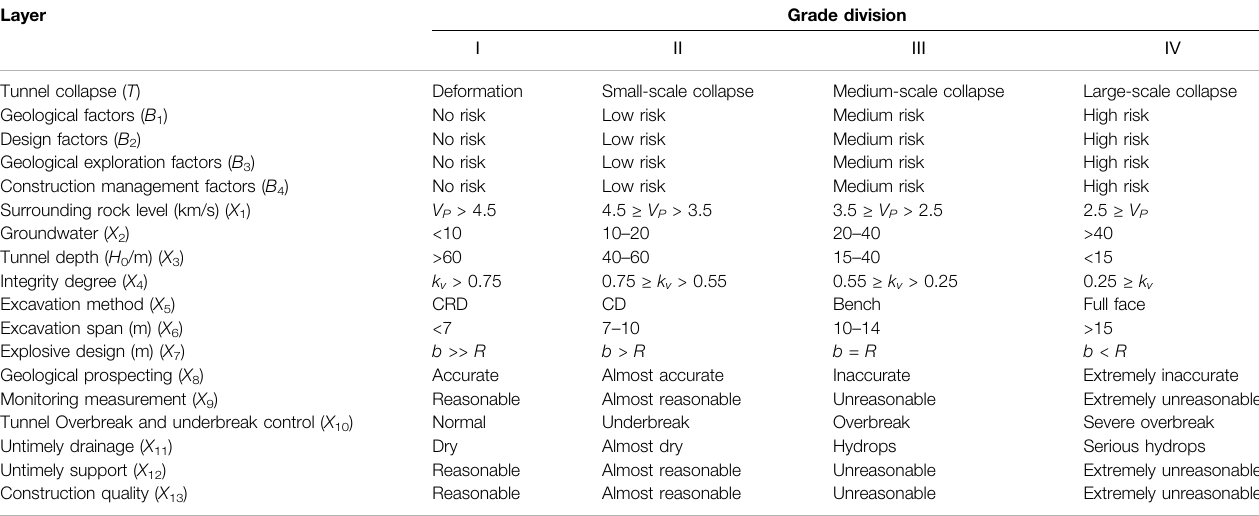
TABLE 3 | Classi fi cation states of the tunnel collapse Bayesian network nodes.